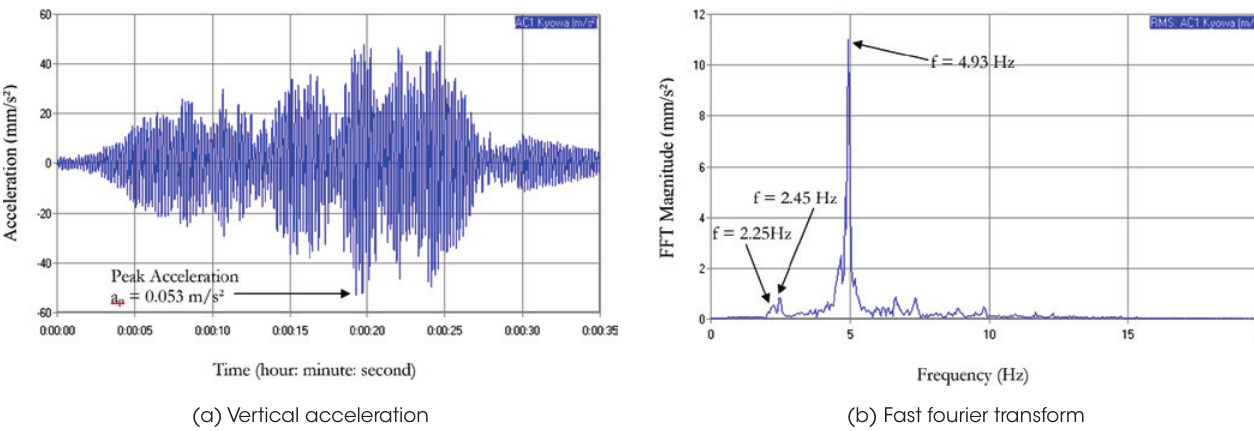
(a) Vertical acceleration Figure 21 Dynamic structural response of the footbridge due to fast walking of 8 people (f